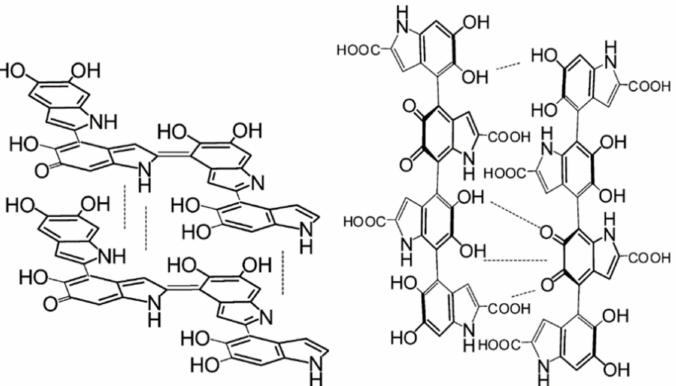
Figure 6. Representative structures of melanins that are DHI ( left ) or DHICA ( right ) based. Reprinted with permission from M. d’Ischia, A. Napolitano, V. Ball et al., Acc. Chem. Res. , 2014, 47, 3541–3550. Copyright 2014 American Chemical Society